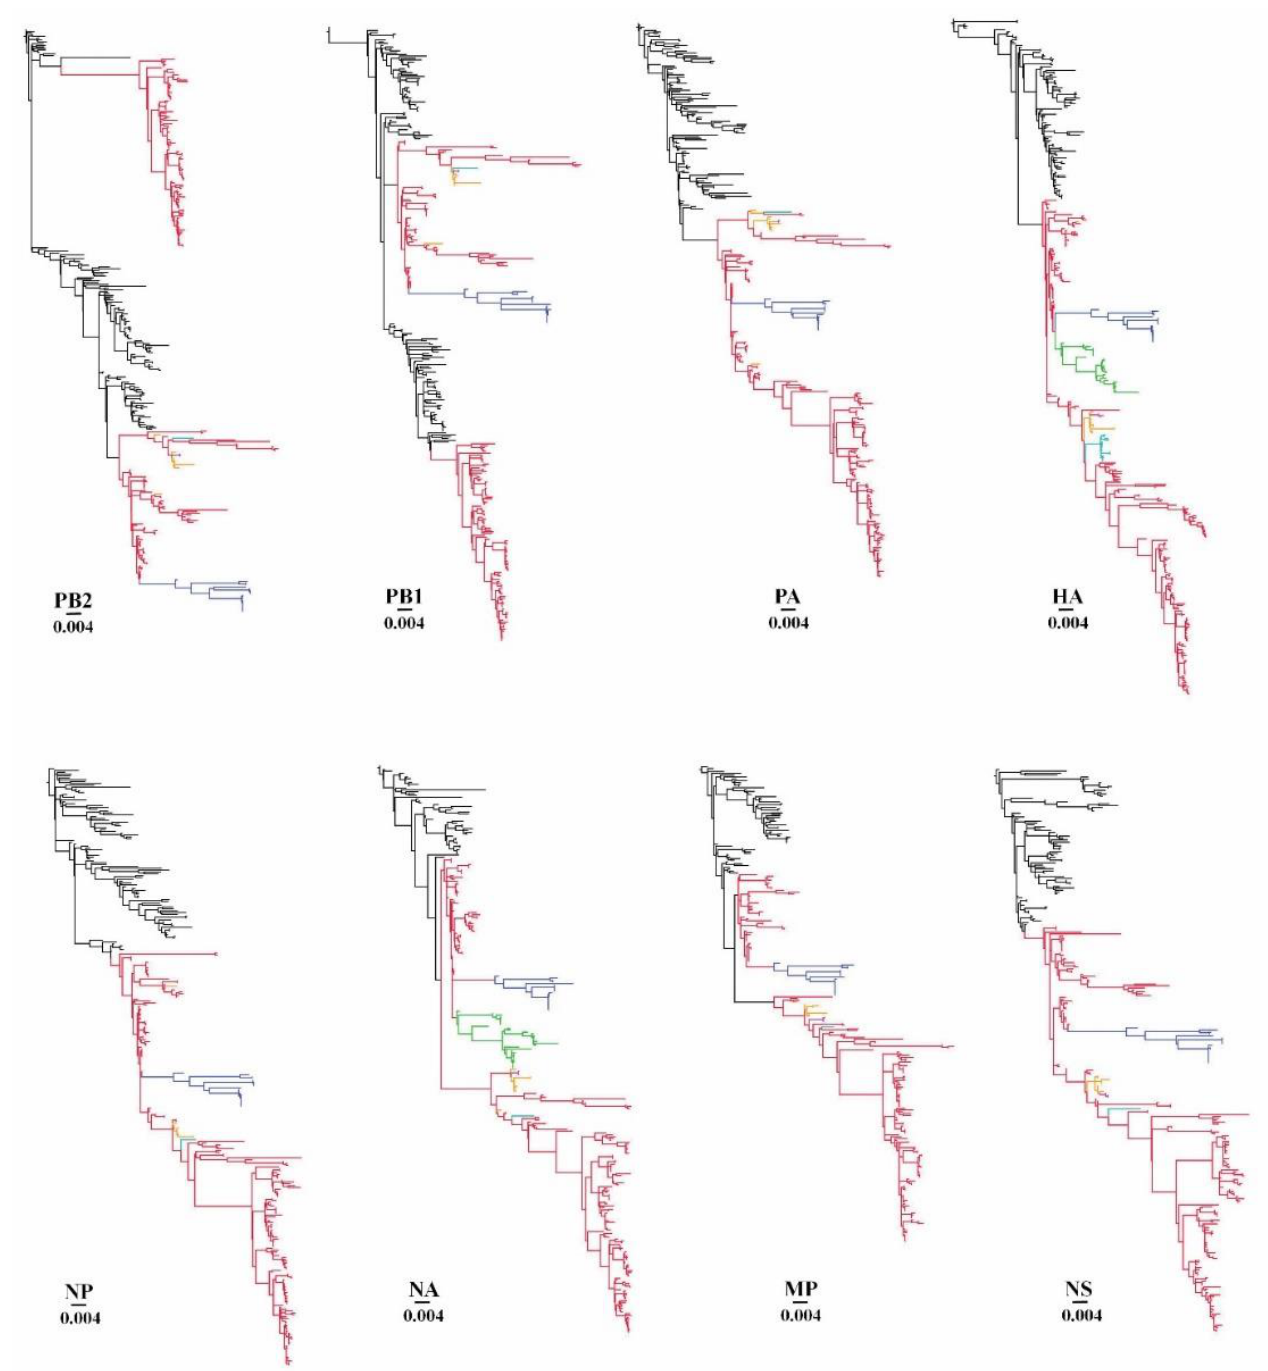
Figure 1. Evolutionary relationships of Mexican lineage H5N2 AIV sequences. The phylogenetic trees for each genome segment were inferred using RAxML. Black branches on the phylogenies represent various subtypes of AIV from the North American wild bird gene pool, while branches leading to enzootic viruses isolated from different geographic regions are color-coded as follows: red, Mexico; yellow, Guatemala; purple, EI Salvador; blue, Dominican Republic; green, Taiwan; cyan, Japan. Horizontal branch lengths are drawn to scale (nucleotide substitutions per site). Each segment tree is rooted on the closest related wild bird AIV sequence in the